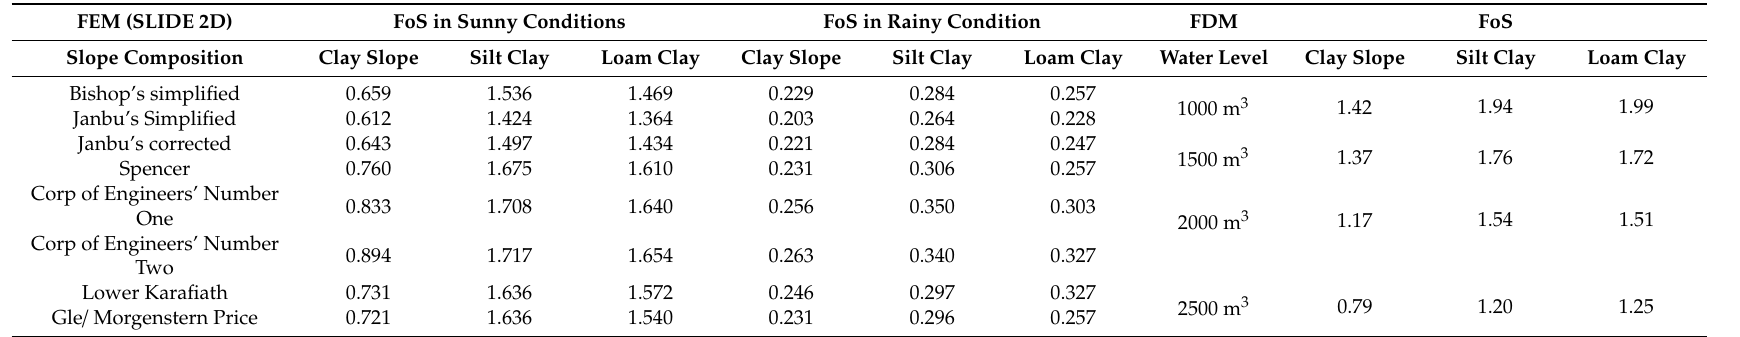
Table 4. Simulated FoS of the slope using di ff erent